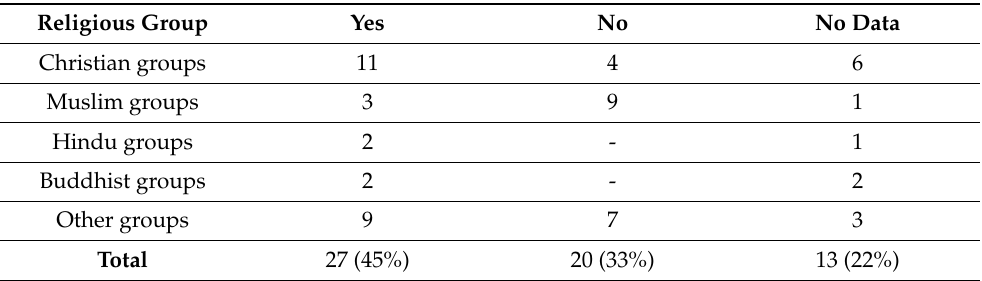
Table 4. Research question 4: Have you continued any of the activities implemented during the first phase of the crisis (i.e., the closure of buildings from March to